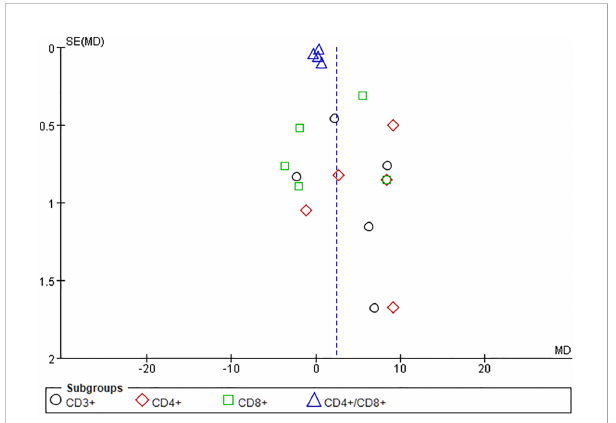
FIGURE 12 Funnel chart based on serum VEGF level after treatment.